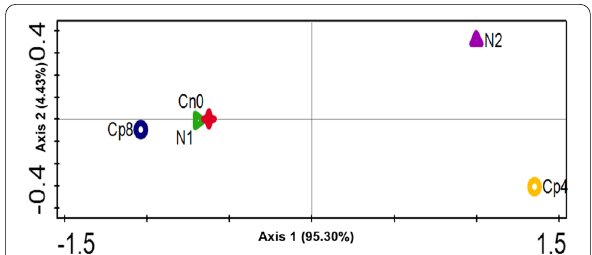
Fig. 4 Principal coordinate analysis (PCoA) of the functional nitrogen cycling genes obtained from the fertilized and unfertilized maize rhizosphere soil samples